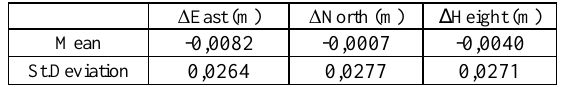
Table 8. Average coordinates differences between points of TLS and photogrammetric models and standard